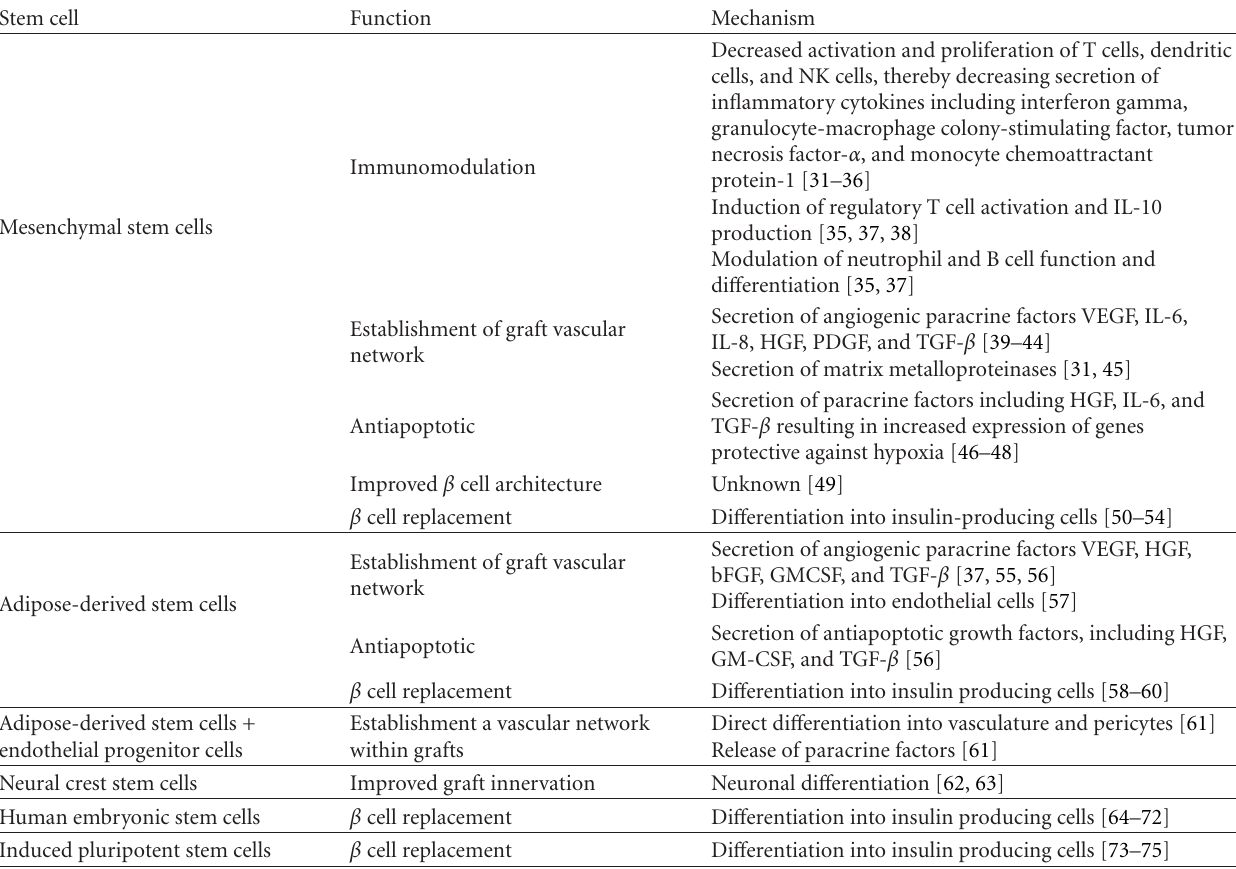
Table 1: Described roles of stem cells in islet